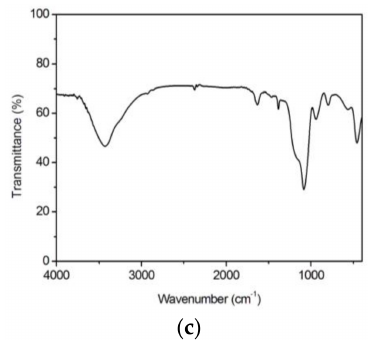
Figure 3. FTIR spectra of some of the samples studied. ( a ) Pure SiO 2 gel; ( b ) La(Ac) 3 doped gel; ( c ) La(NO 3 ) 3 doped gel.